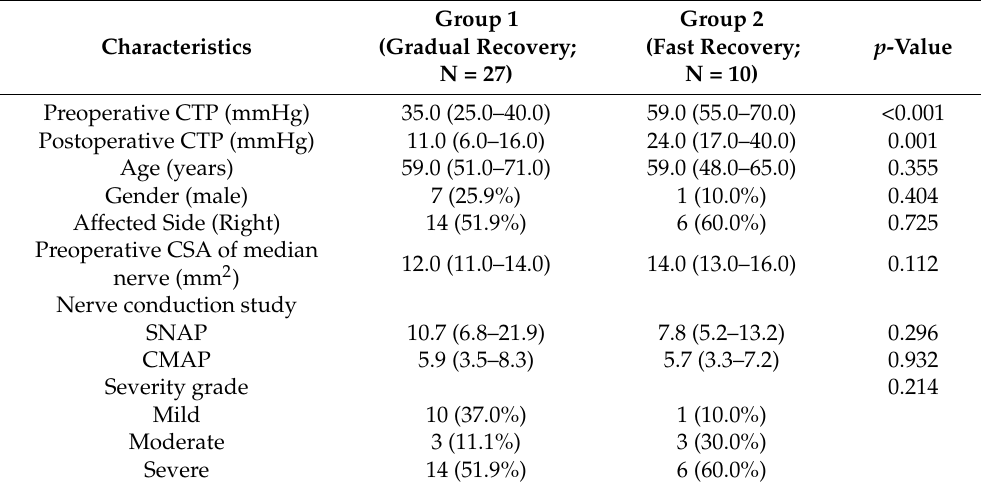
Table 3. Comparisons of clinical characteristics of patients between gradual and fast recovery groups. Group 1 Characteristics (Gradual Recovery; Preoperative CTP (mmHg)